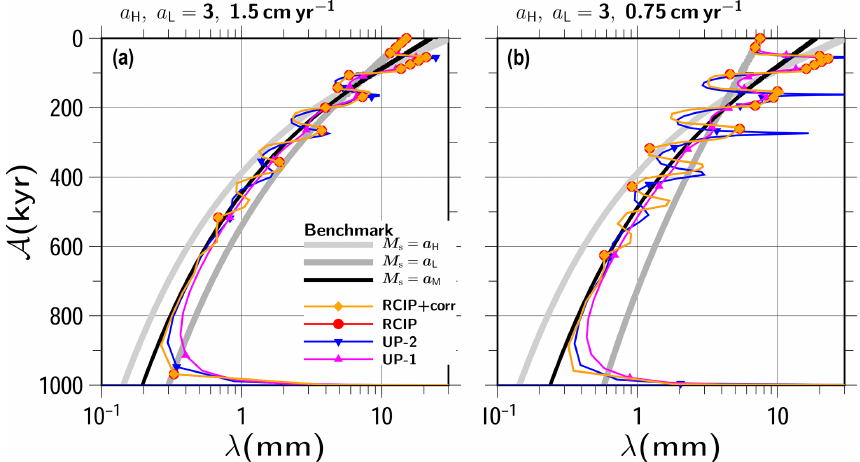
Figure 10. Results of transient experiments with square-wave surface mass balances of (a) a H ,a L = 3 and 1.5cmyr − 1 and (b) 3 and 0.75cmyr − 1 with high- and low-value phase durations (Eq. 57) set as P H : P L = 1 : 1 = 50 : 50kyr. The basal mass balances are set as 0. The computed annual layer thickness of λ against the computing age is shown ( RCIP overlaps with RCIP+corr ). The gray lines indicate benchmark solutions of the constant surface mass balance cases of a H and a L , while the black lines a M = (a H + a L )/ 2 are provided as references. Uniform grid spacing of 129 levels is adopted in this simulation.